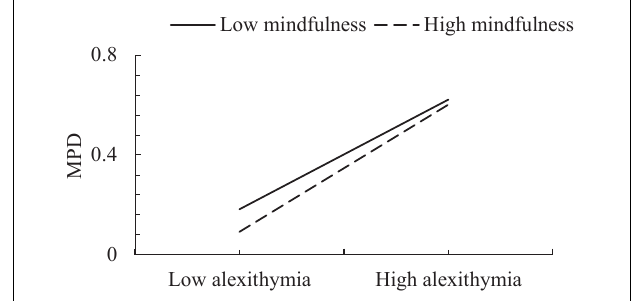
FIGURE 2 | The association between alexithymia and MPD as a function of mindfulness level (low vs.